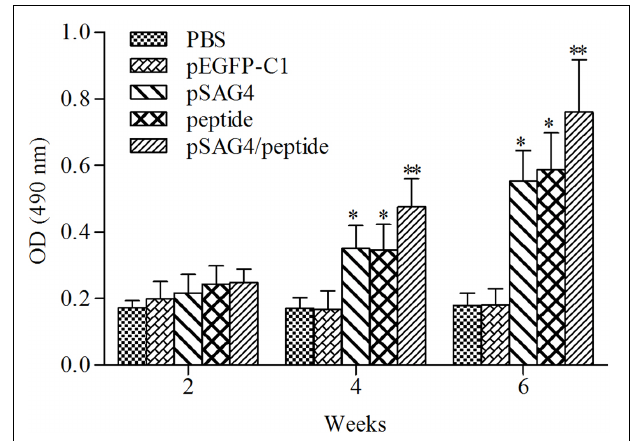
FIGURE 4 | Measurement of specific IgG antibodies in immunized sera of mice. Twenty blood samples of each group were collected from caudal vein on days 13, 27, and 41. Results are expressed as means of the OD490 of the samples. T. gondii -specific IgG was used in the study. All the samples were run three times. ∗ Compared with PBS or pEGFP-C1, p < 0.05 and ∗∗ compared with pSAG4 or peptide, p < 0.05.